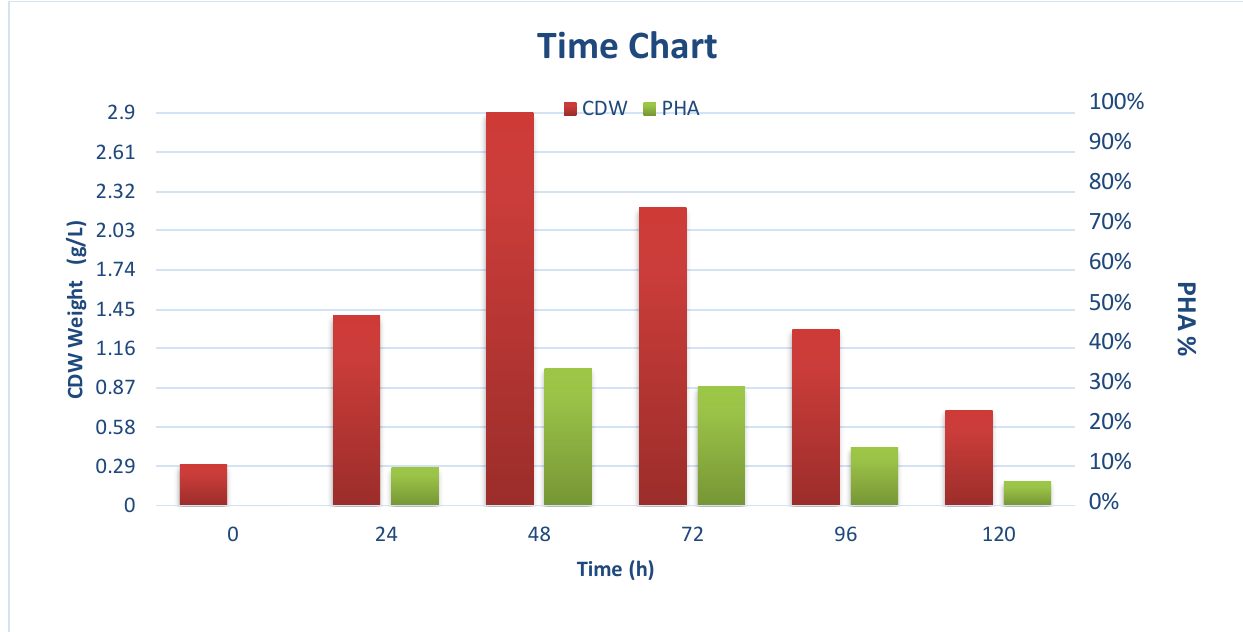
Figure 3: Effect of incubation time on growth rate and PHA production by A. lwoffii